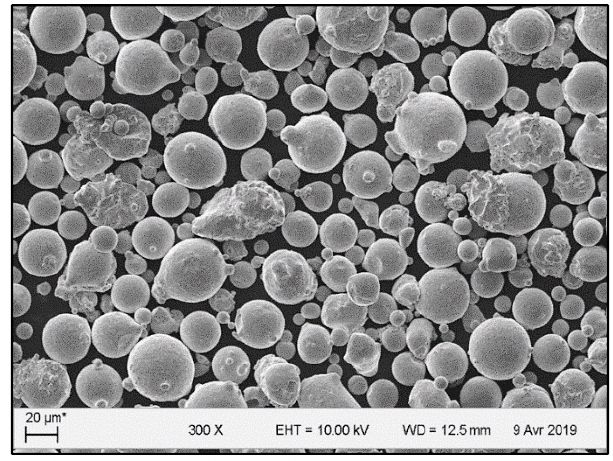
Figure 4. Scanning electron microscopy of the IN625 gas-atomized powder used in this study. The observations revealed mostly spherical particles.